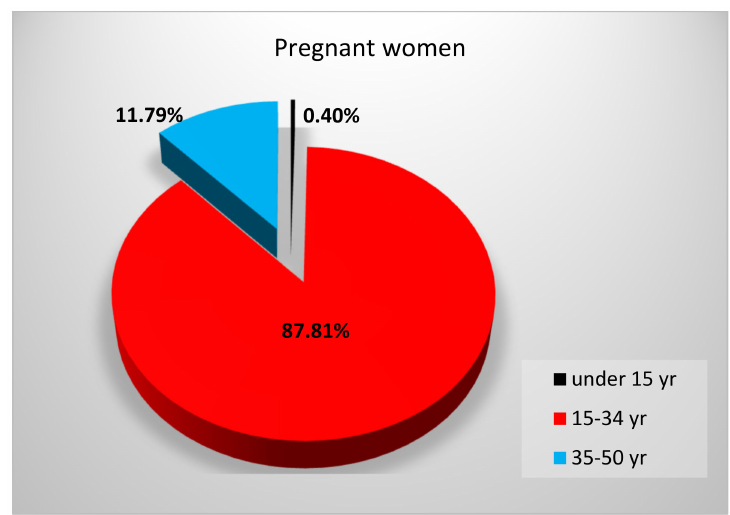
Figure 5. Percentages of Romanian pregnant women by different age categories in 2017.